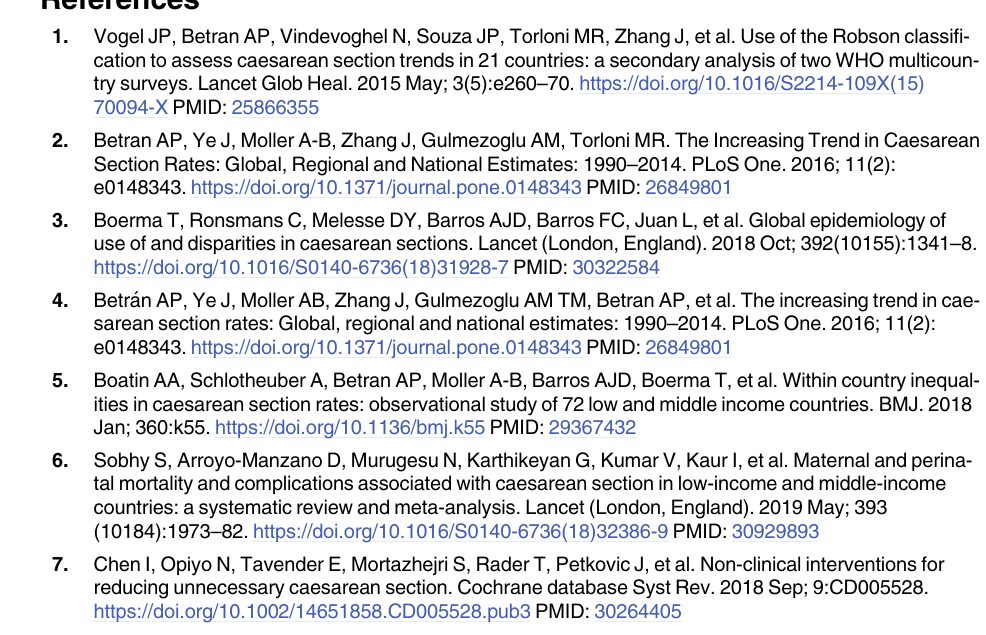
S3 Table. Assessment of methodological limitations. S4 Table. Evidence profile. S5 Table. Supporting quotes for final themes, initial concepts and emergent